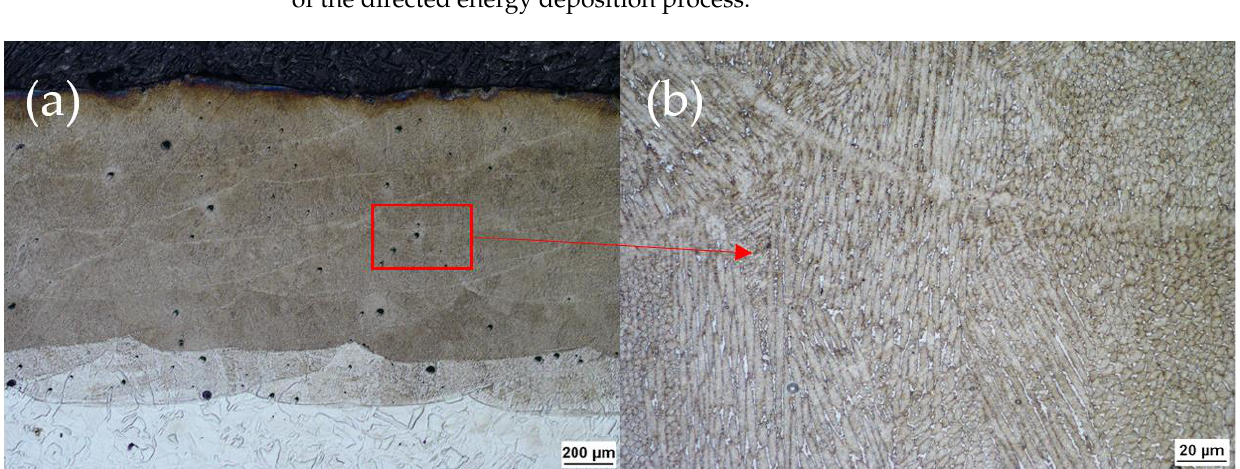
Figure 10. 5_T specimen showing ( a ) different microstructures in the coating, between the first and subsequent layers, and ( b ) complete martensitic microstructure in the upper layers.